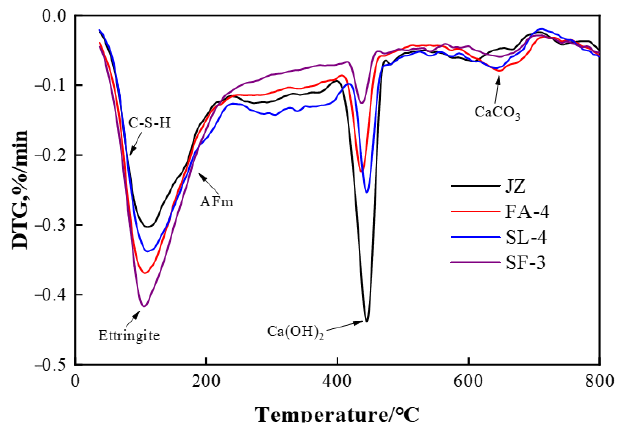
Figure 12. DTG curve of cement mortar slurry.